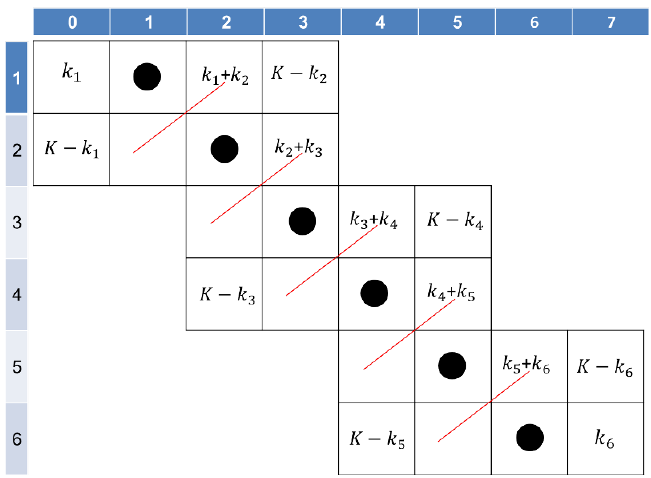
Figure 8 . This (cid:12)gure shows the number of interacting modes from every hypermultiplet in the case described in 5.1. Every pair of scalars q ab ; q ba give rise to k a + k b o(cid:11)-diagonal modes. Their boxes are connected by red lines and the number of modes is written only in one of the boxes. The size modes appear in the boxes without red line on them. Simple counting results in ( M + 2) K